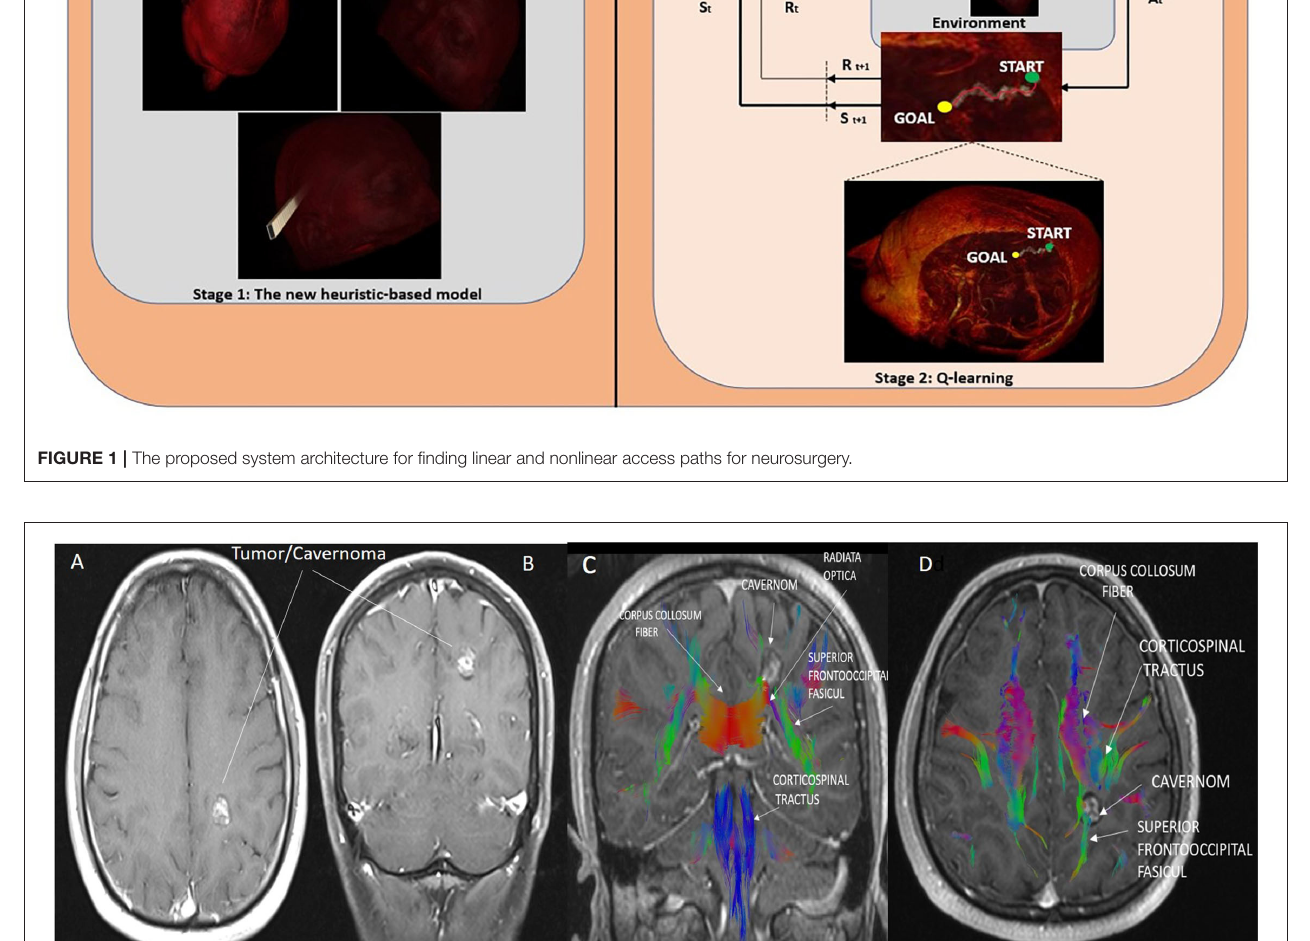
FIGURE 2 | (A,B) Cavernoma appearance on axial (A) and coronal (B) contrast-enhanced T1 cranial MRI images. (C,D) The anatomical relationship of the corticospinal tract, superior fronto occipital fasciculus, and corpus callosum transverse fibers with the cavernoma is shown in sagittal and axial MRI tractography images. Due to the mass effect of the cavernoma, displacement of the superior fronto occipital fasciculus was observed.